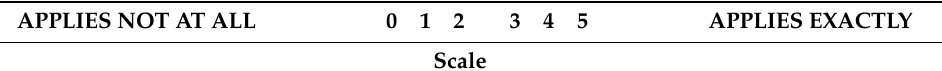
Table A1. Embodied Intersubjectivity Scale—EIS